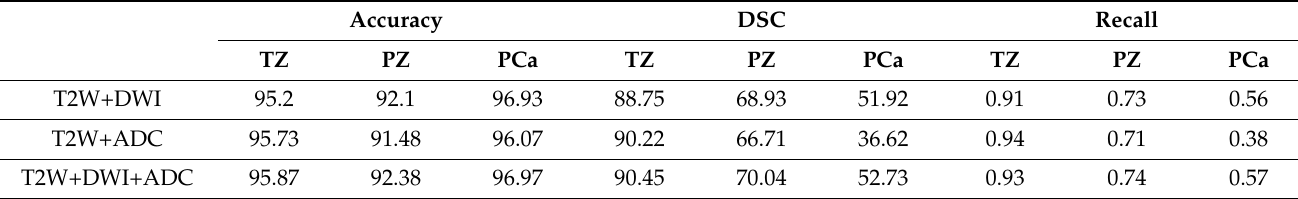
Table 2. Results of multiclass segmentation on different combination of SegNet-like